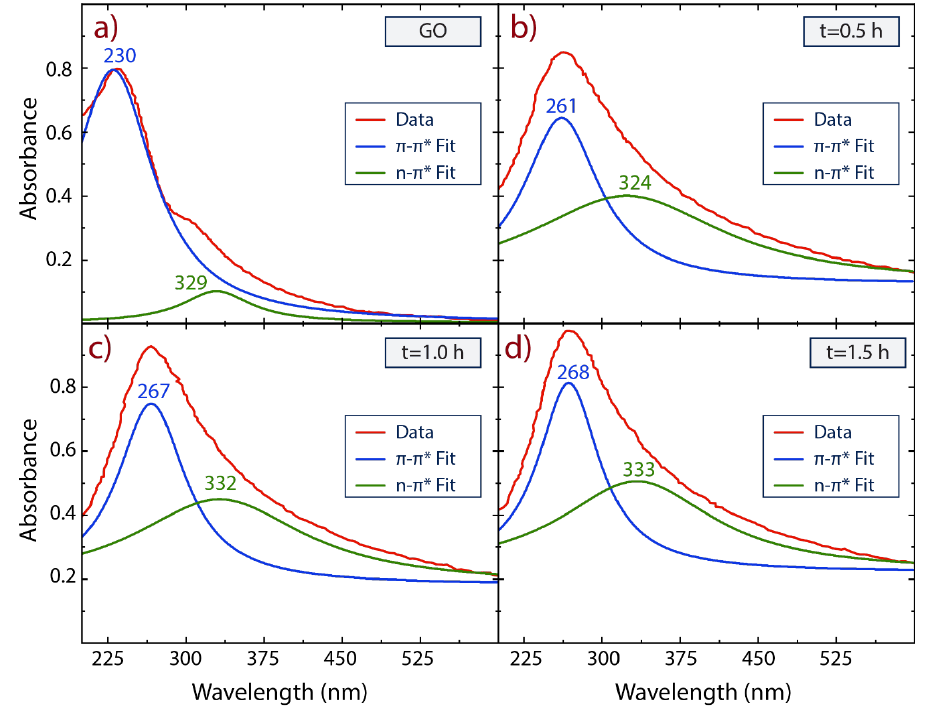
Figure 2. UV-Vis spectra recorded in aqueous solution at 0.1 mg/mL of ( a ) GO and ( b – d ) rGO as a function of the reduction time by using citric acid. The characteristic absorbance peak of GO and rGO were fitted with two Lorentzian functions.